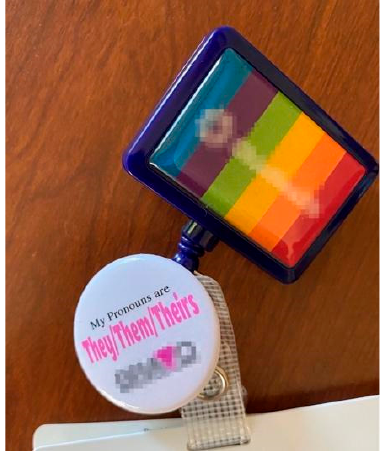
Figure 4. “Hi my name is [E.] and my pronouns are they/them” (E.).